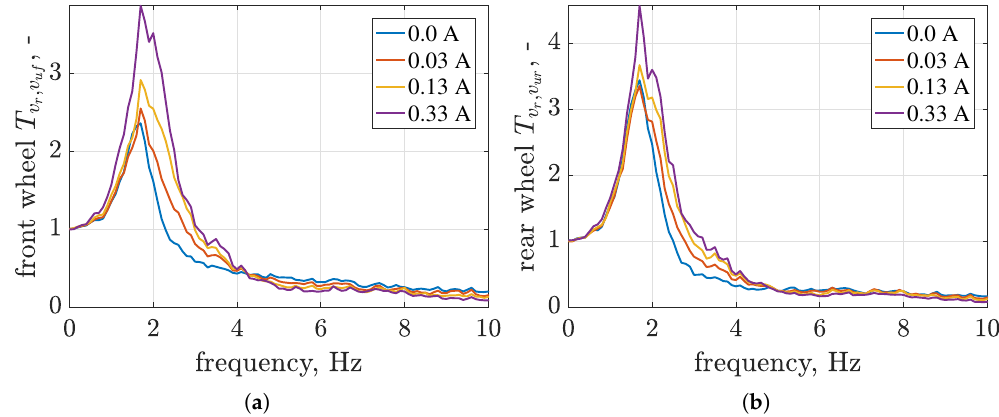
Figure 11. Transmissibility characteristics of vertical wheel velocity for passive suspension and constant vehicle longitudinal velocity equal to 5 ms − 1 : ( a ) front wheel, ( b ) rear wheel.